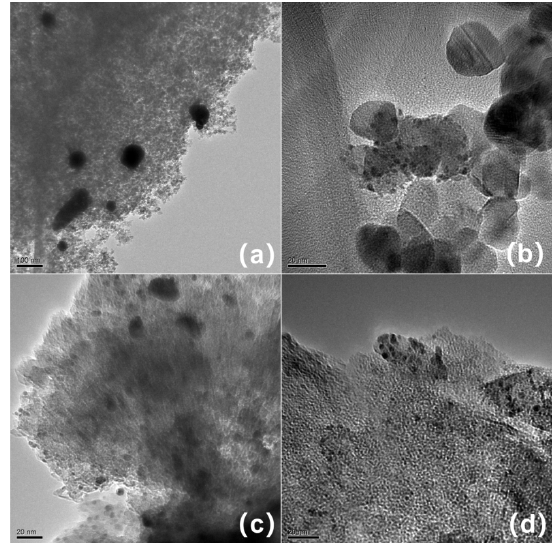
( a ) Au/SiO ; ( b ) Au/ZnO; ( c ) Au/Al 2 from [25]. Copyright 2011 Elsevier